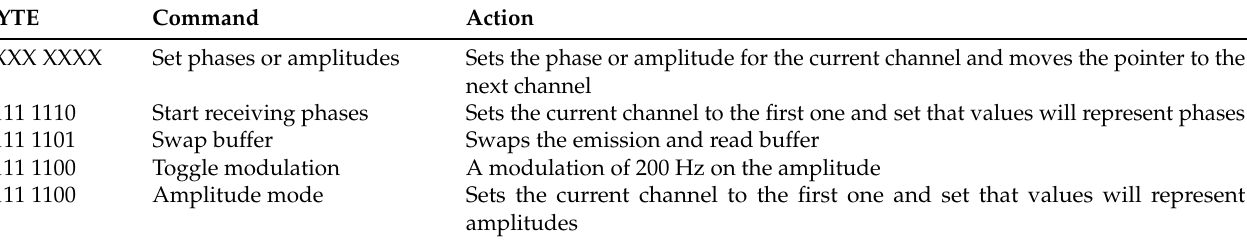
Table 1. Communication protocol